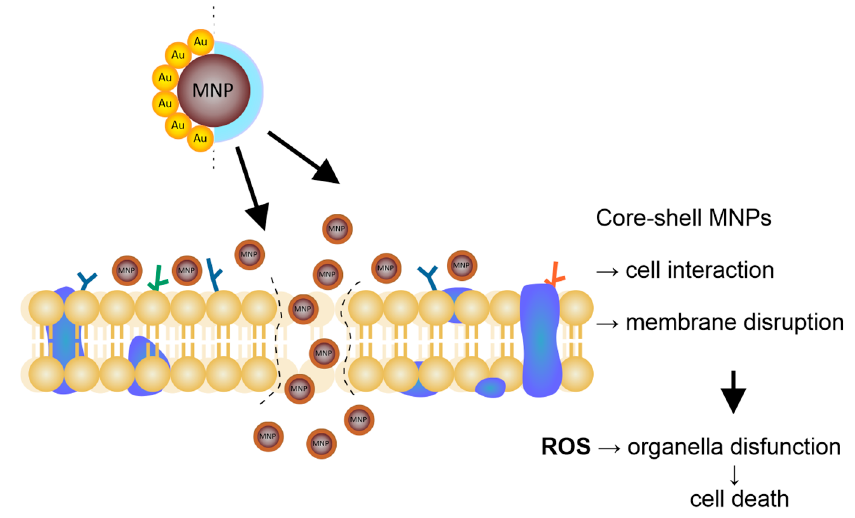
Figure 2. The mechanism of nanoparticles’ activity within the cell membrane and cytosol.